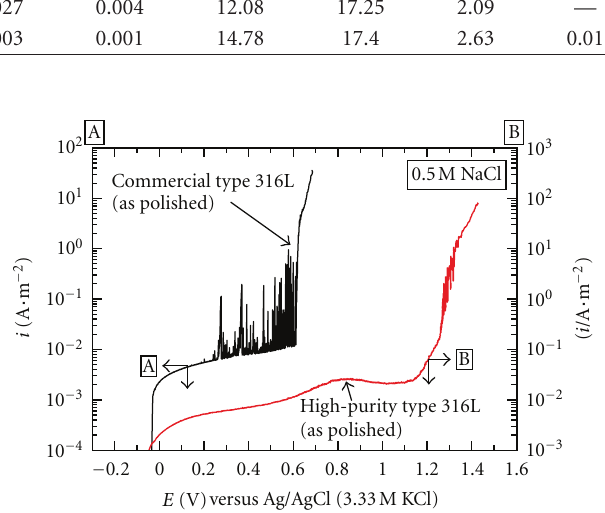
Figure 1: Anodic polarization curves of commercial Type 316L and high-purity Type 316L stainless steels in 0.5 M